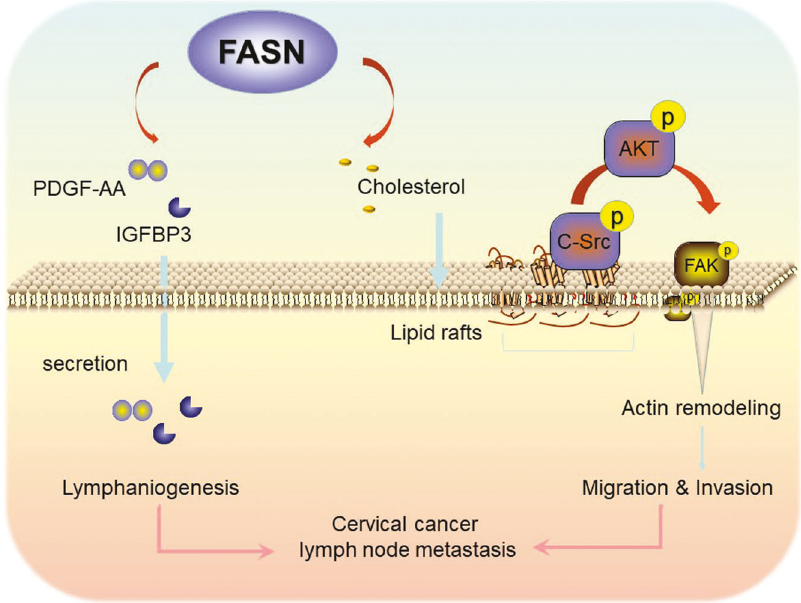
Fig. 8 FASN promotes lymph node metastasis in cervical cancer via cholesterol reprogramming and lymphangiogenesis. Proposed schematic representation of the mechanism demonstrating that FASN promotes lymph node metastasis in cervical cancer via cholesterol reprogramming and